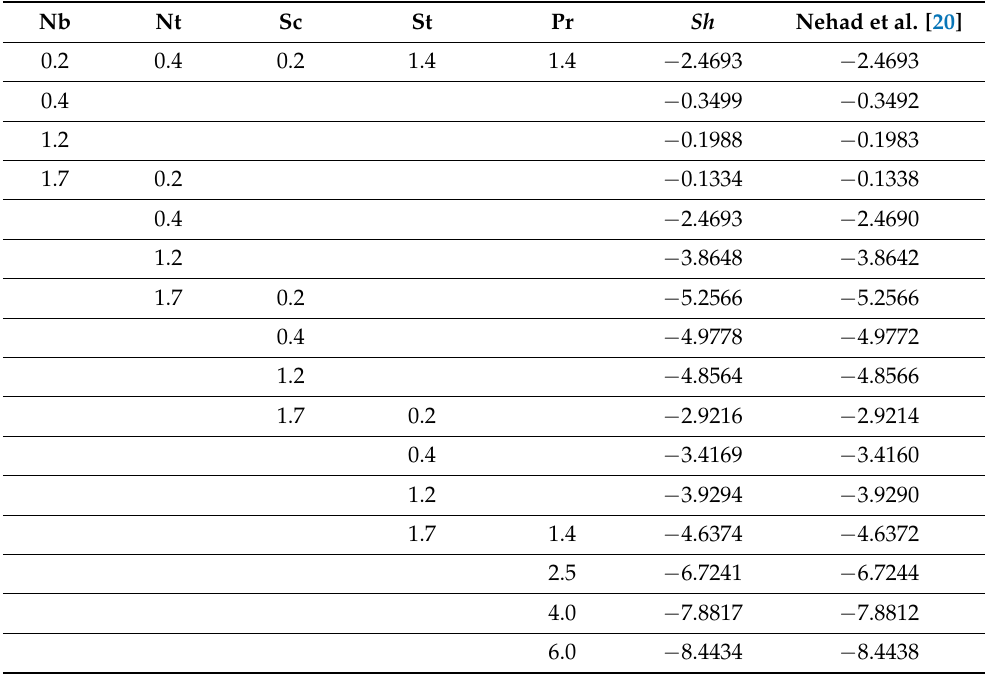
Table 4. Influence of Nb, Nt, Sc, Pr, and St, on Sherwood Number and its stability.